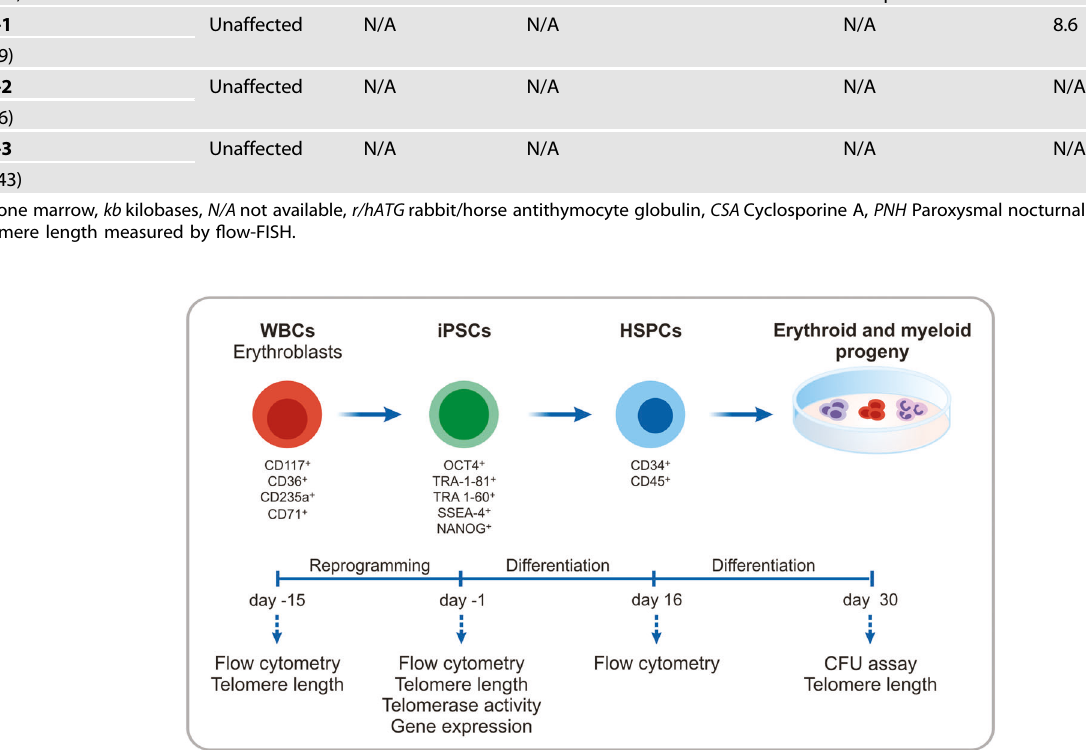
Fig. 1 Schematic representation of experiments performed for modeling AA in vitro. WBCs, White Blood Cells; iPSCs, induced Pluripotent Stem Cells; HSPCs, Hematopoietic Stem and Progenitor Cells; CFU, Colony-Forming